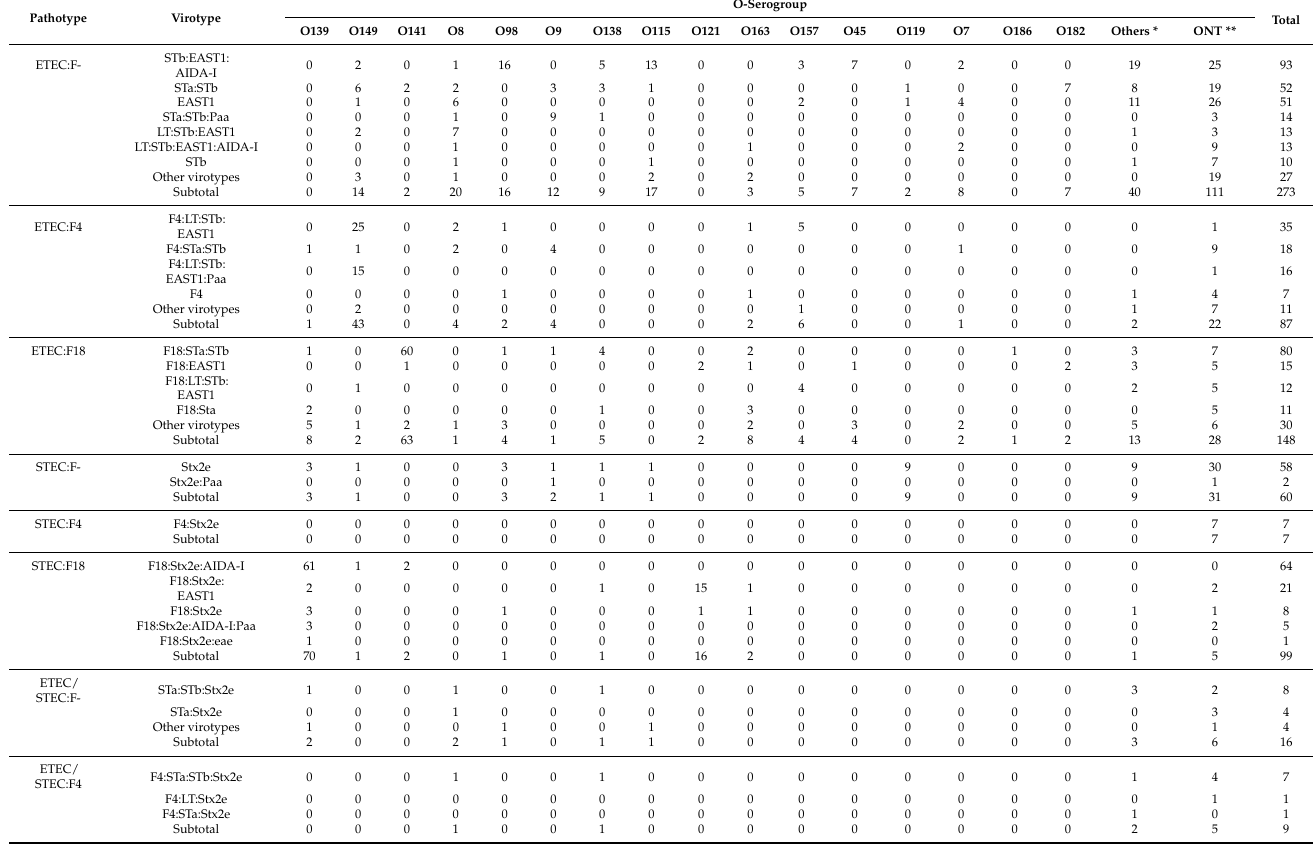
Table 1. O-serogroup and pathovirotypes of E. coli detected in post-weaning piglets.